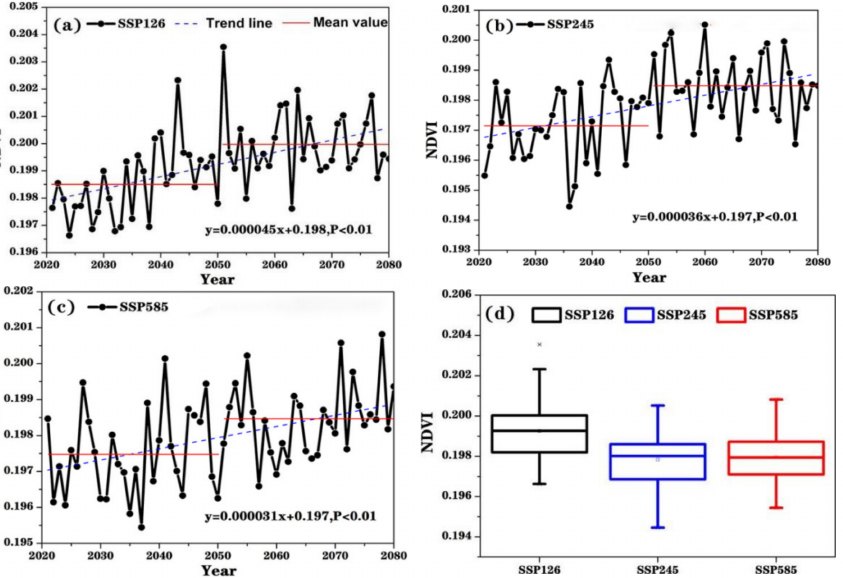
Figure 13. Temporal trends in the normalized difference vegetation index (NDVI) on the Mongolian Plateau under different SSP scenarios.(( a – c ): Temporal trends of NDVI in SSP126/SSP248/SSP585 scenarios from 2012 to 2080, ( d ): Stability of NDVI changes in SSP126/SSP248/SSP585